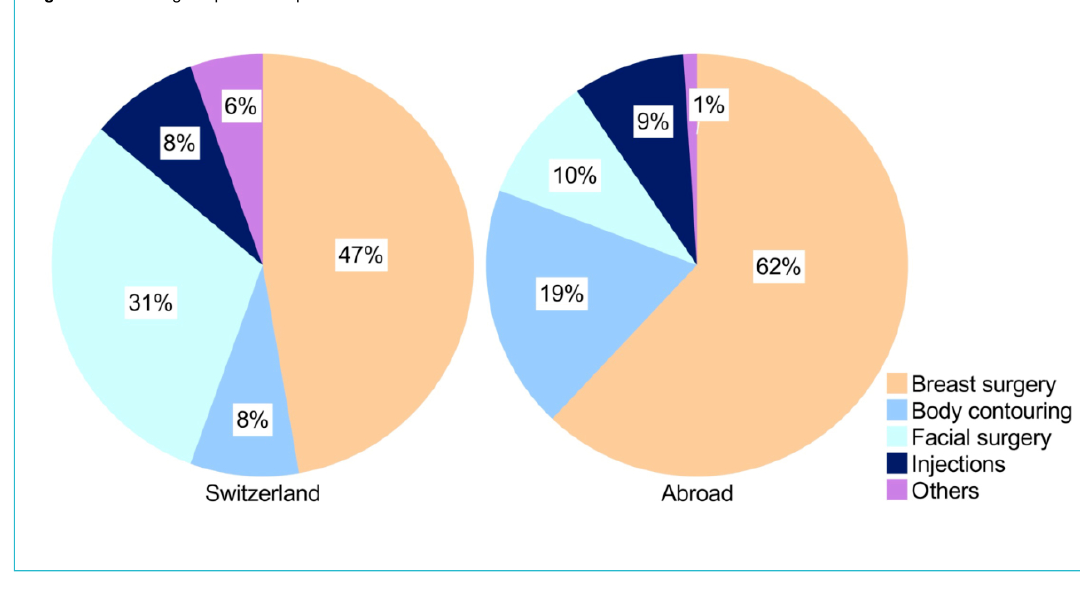
Figure 3: Percentage of performed procedures.